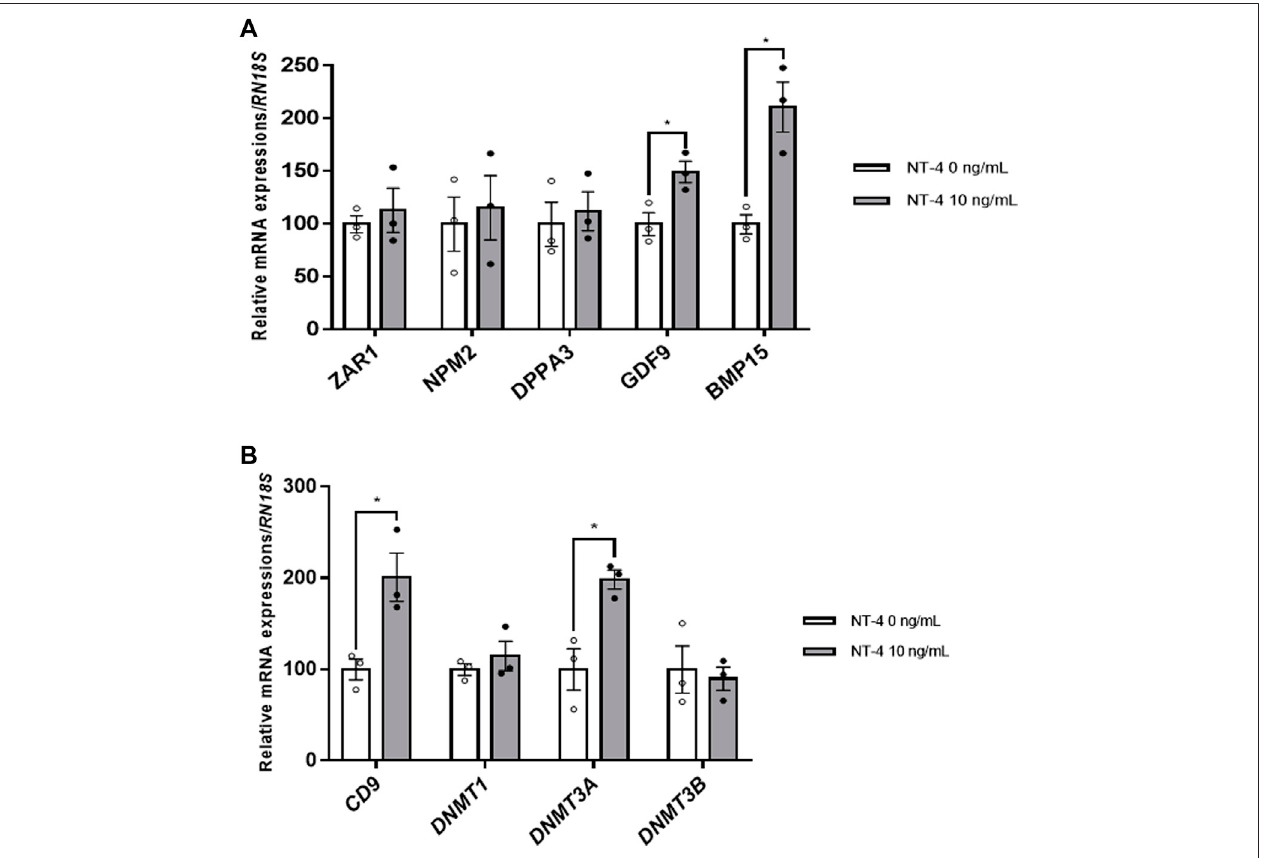
FIGURE3| RelativemRNAexpressionlevelsofmaternalfactors,theregulatorofsperm – oocyteinteractions,andDNAmethylation-relatedgenesinneurotrophin-4 (NT-4)-treatedporcineoocytes. (A) mRNAexpressionlevelsofmaternalfactor-relatedgenes( ZAR1 , NPM2 , DPPA3 , GDF9 ,and BMP15 ) (B) mRNAexpressionlevelsof the regulator of sperm – oocyte interactions ( CD9 ) and DNA methylation-related genes ( DNMT1 , DNMT3A , and DNMT3B ). Values represent the mean ± SEM. * p < 0.05 ( t -test). The experiment was replicated at least three times.